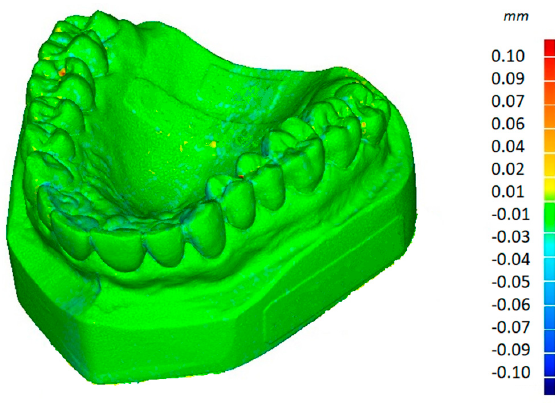
Figure 7. One of the repeatability tests.